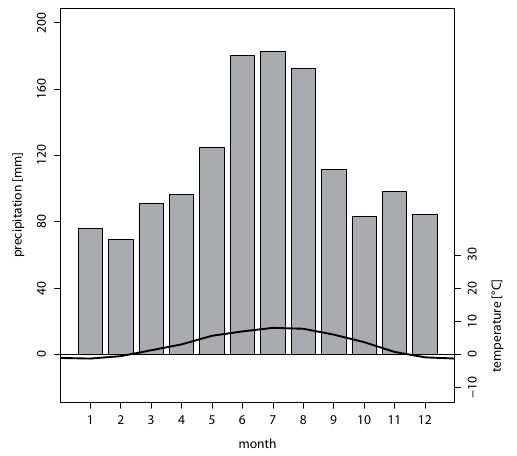
Fig. 1. Climograph for the meteorological station Garmisch- Partenkirchen (719ma.s.l., 47.48 ◦ N, 11.06 ◦ E); black line: mean monthly temperature, grey bars: mean monthly precipitation sums, reference period: